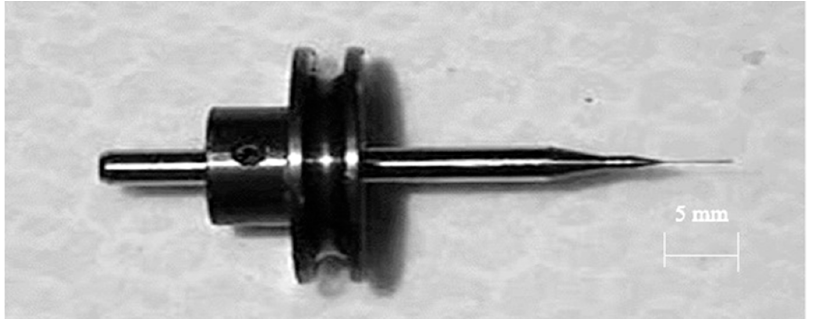
Figure 5. Spindle micro-tool with pulley.